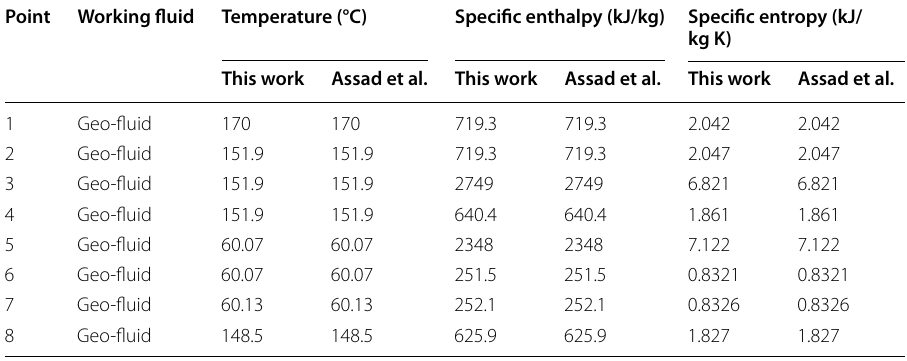
Table 2 Validation of the basic single flash geothermal cycle simulation compared with Assad et al.’s results (Assad et al.